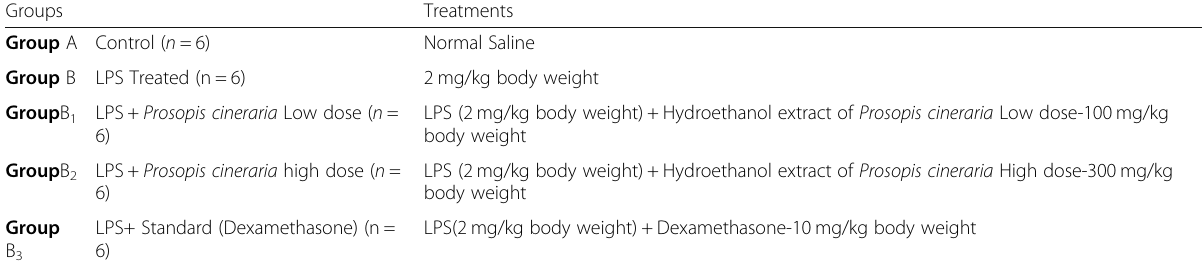
Table 1 Representation of groups of experimental animals and the treatment to which were subjected Groups Treatments Group A Control ( n = 6) Normal